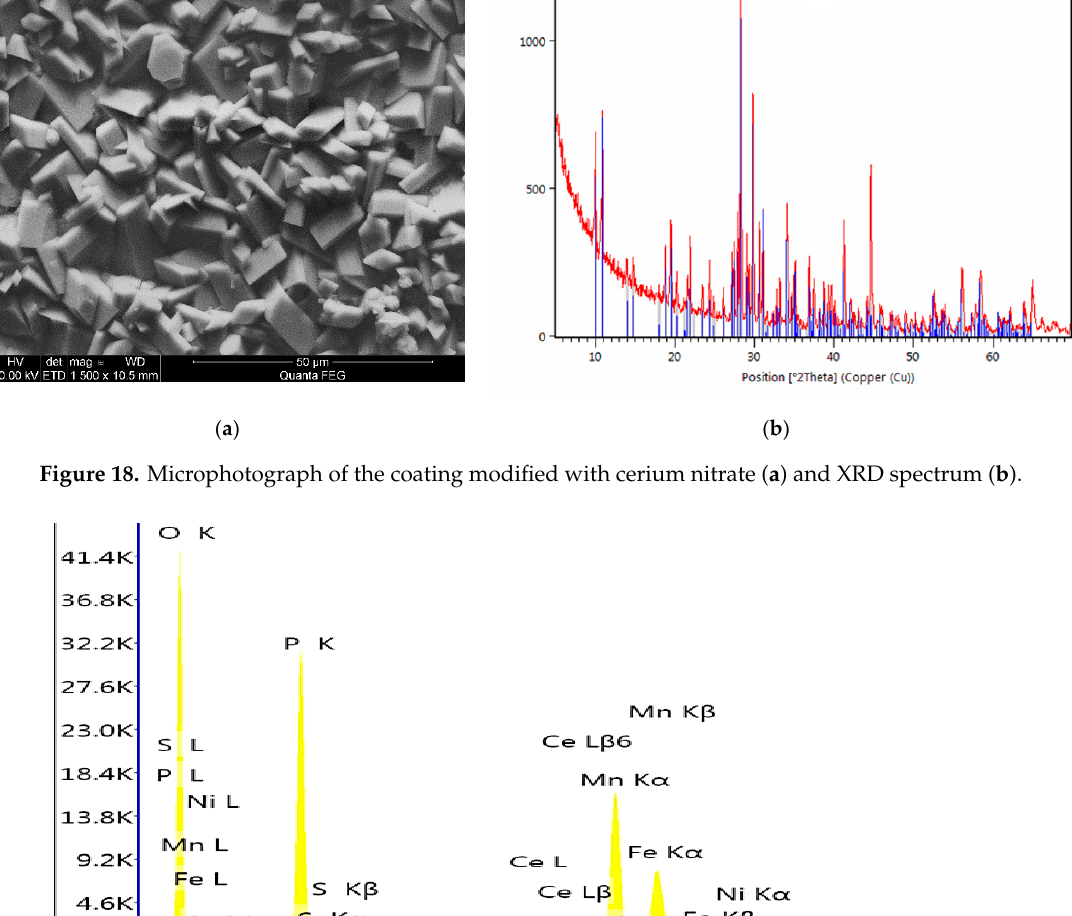
Figure 18. Microphotograph of the coating modified with cerium nitrate ( a ) and XRD spectrum ( b ).